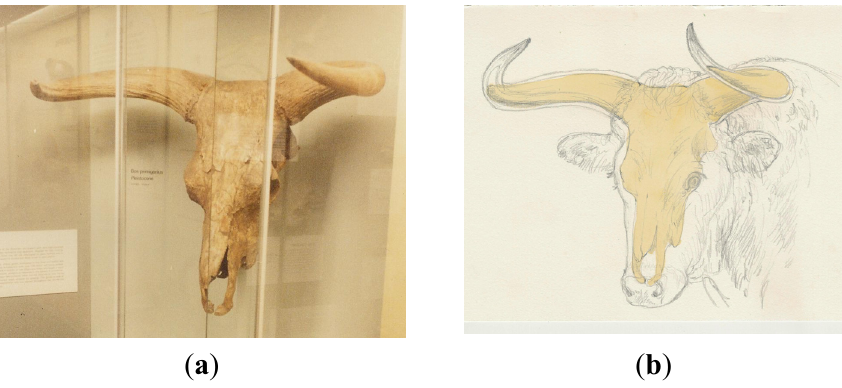
Figure 4. ( a ) Skull of an aurochs bull (The British Museum) and ( b ) reconstruction (drawing by Marleen Felius) .